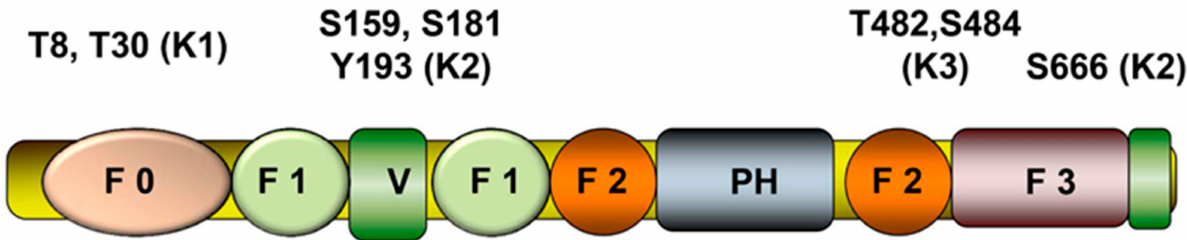
Figure 1. Domain structure of a prototypic kindlin with functionally important phosphorylation sites